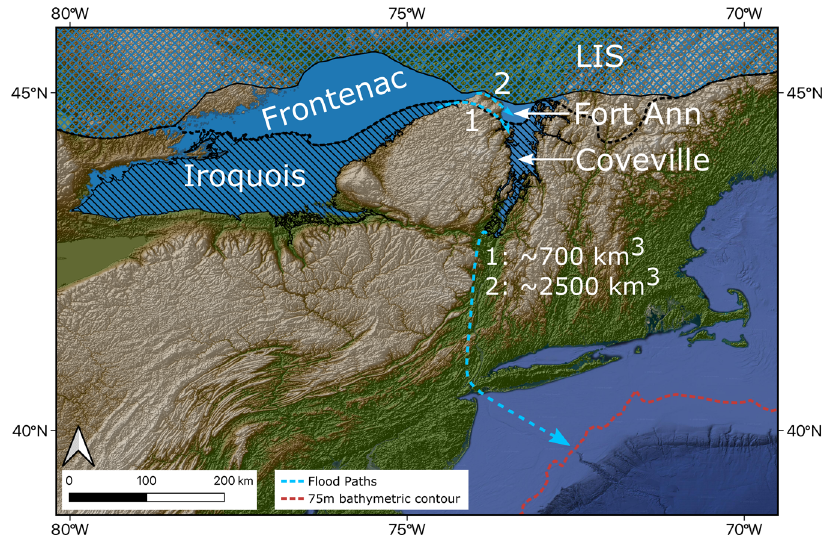
Fig. 1 Hudson Valley glacial fl oods during deglaciation. Approximate extents of relevant glacial lakes impounded by the retreating Laurentide Ice Sheet (LIS; blue double-hashed area) in St. Lawrence and Champlain Valleys and fl oodwater pathway out the paleo-Hudson River. Lake Iroquois, and Coveville (hashed areas) contributed to the fi rst fl ood (1) of ~700 km 3 followed by a larger fl ood draining both Lake Frontenac and Fort Ann (blue area; ~2500 km 3 ). Lake and LIS extents adapted from Rayburn et al. 10 , Bird and Kozlowski 41 , and Franzi et al. 11 . Topography and bathymetric imagery and data from the General Bathymetric Chart of the Oceans and Map Data © 2019 Google, NOAA, U.S. Navy, NGA, SIO, and